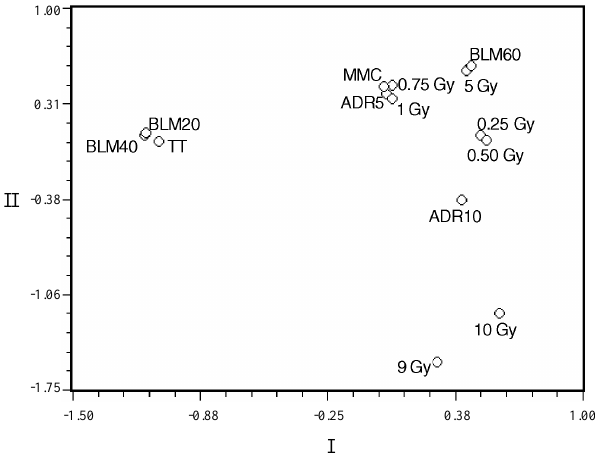
Figure 3 - Multidimensional scaling graph, showing the location of the 14 treatments in a bidimensional graph (axis I-II, 56.88% of variance). The final “stress” was 0.03893. See references on Material and Methods, and Table I.